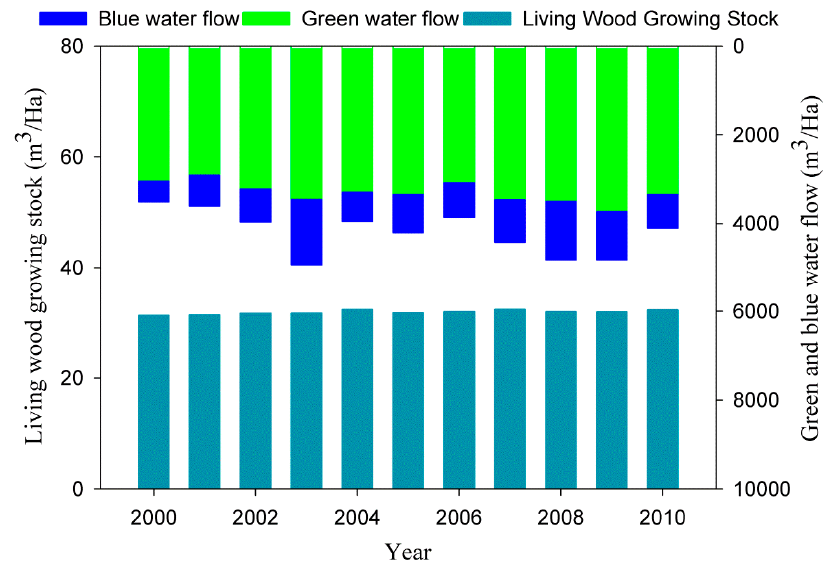
Figure 6. Ecosystem services of green and blue water flow for grasslands.